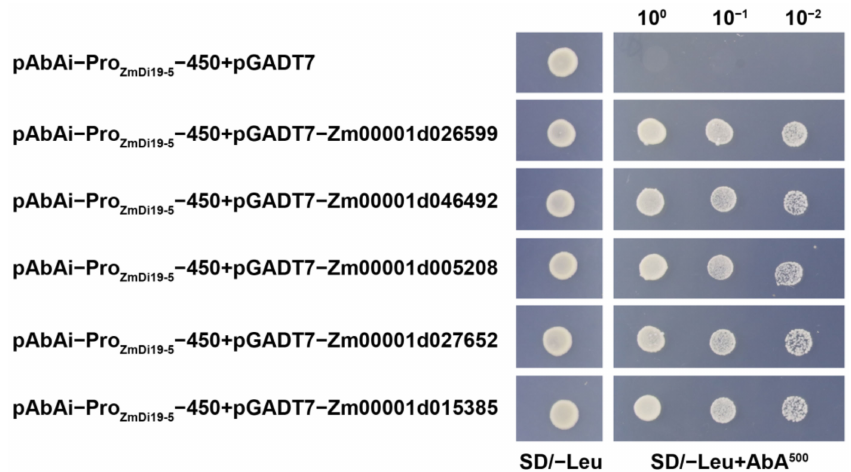
Figure 10. Binding activity of five important proteins to the core region of ZmDi19-5 promoter by